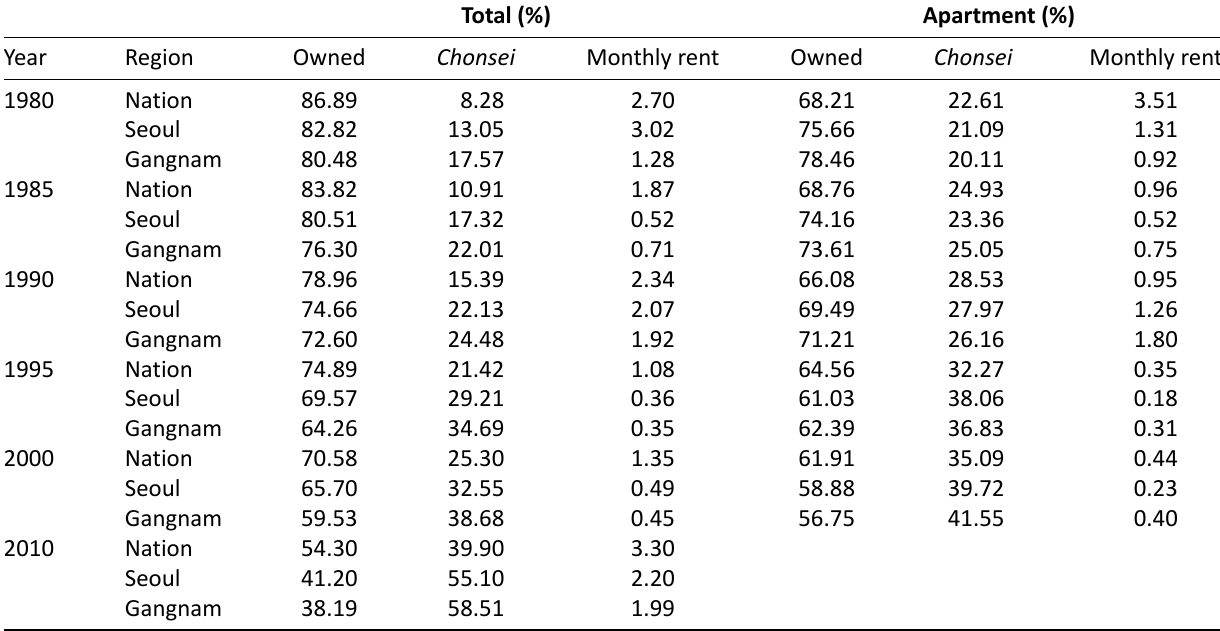
Table 2. Housing tenure ratio.